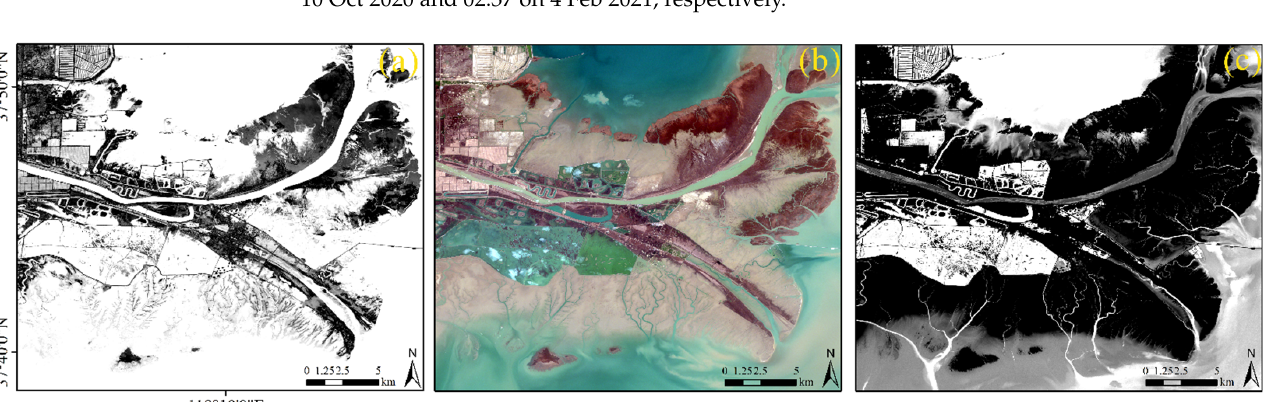
Figure 8. Exhibition of tidal flats range from the Murray_TF [1], our result (”This study”), and tidal wetlands range from Zhang_TW [10] in the Yellow river delta (region A), Liao Estuary (region B) and Haeju bay (region C), which are overlaid on the lowest-tide Sentinel-2 images acquired at 02:57 on 2 Mar 2021, 02:46 on 39 Mar 2021 and 02:37 on 17 Oct 2020, respectively. The last row represents the highest-tide Sentinel-2 images. From left to right, they are acquired at 02:57 on 10 Feb 2021, 02:47 on 10 Oct 2020 and 02:37 on 4 Feb 2021, respectively.